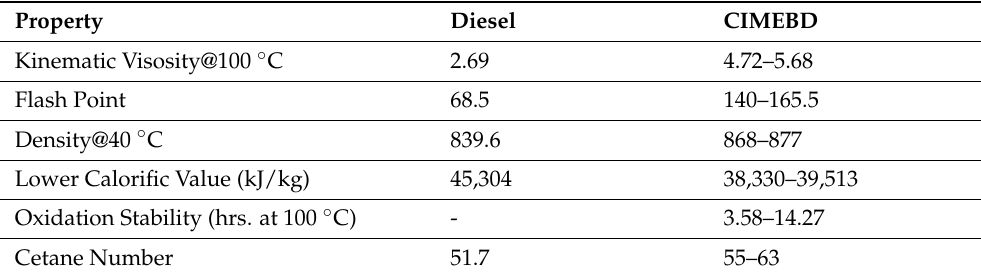
Table 1. Properties of CIME